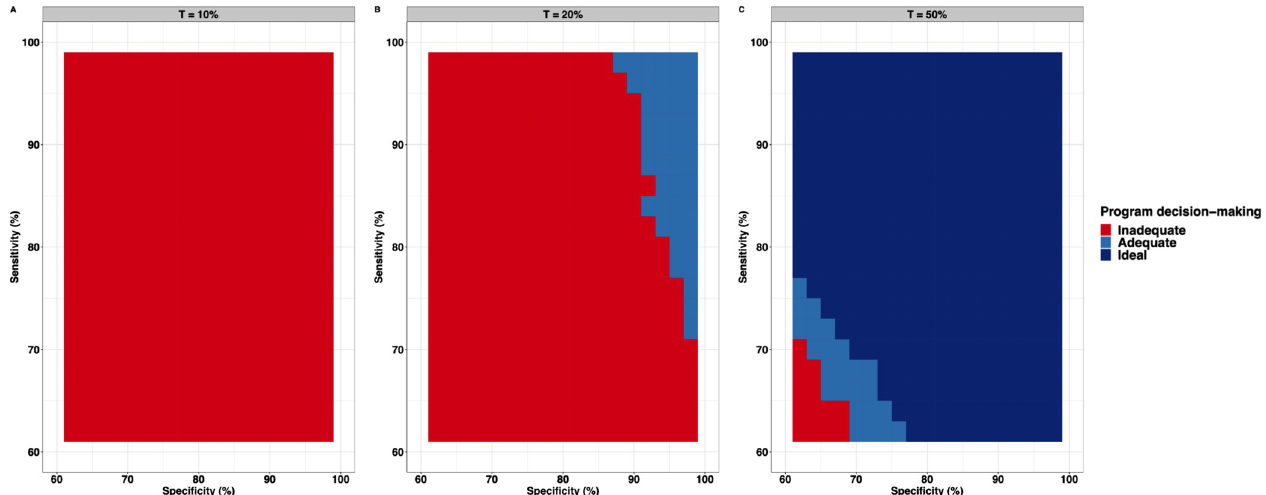
Fig 4. The required sensitivity and specificity when applying the current WHO study design. This figure indicatesthe required sensitivity and specificity when applying the current WHO study design ( n clust = 5 and n sub = 50 )that allow for adequate ( E ( E ¼ 10 % and E ¼ 5 % Þ decision-making around each of the four program prevalence thresholds T ( PanelA :10%; Panel B :20%; Panel C :50%). The overtreat undertreat intra-cluster correlation ρ i was fixed at 0.02, and the limits of the grey zone were defined as a proportion of the program prevalence threshold T ð LL ¼ T (cid:0) 0 : 25 � T ; UL ¼ T þ 0 : 25 � T Þ . The red area indicates that the combination of the surveydesign ( n clust , n sub ) and the test performance ( se d and sp d ) was inadequate for decision-making, while the light blue and the dark blue represent combinations that allow for adequate ( E and ideal ð E ¼ 10 % and E ¼ 5 % Þ decision-making, respectively. All graphs are based on the same set of 10,000 Monte Carlo simulations. overtreat undertreat